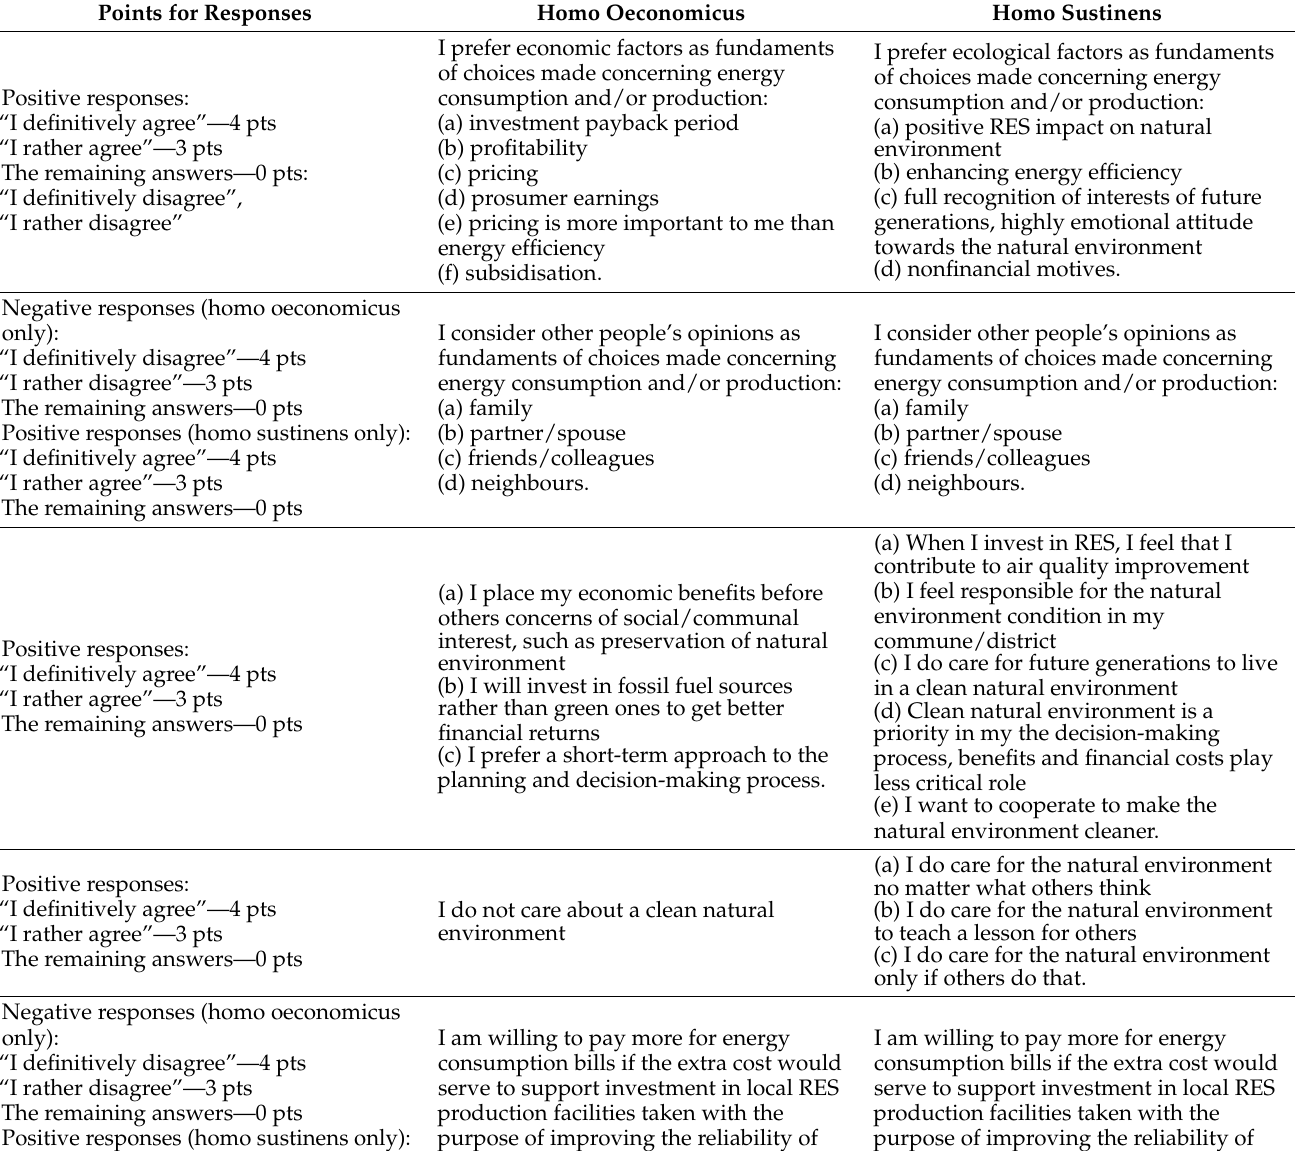
Table 3. Qualification method for homo oeconomicus and homo sustinens